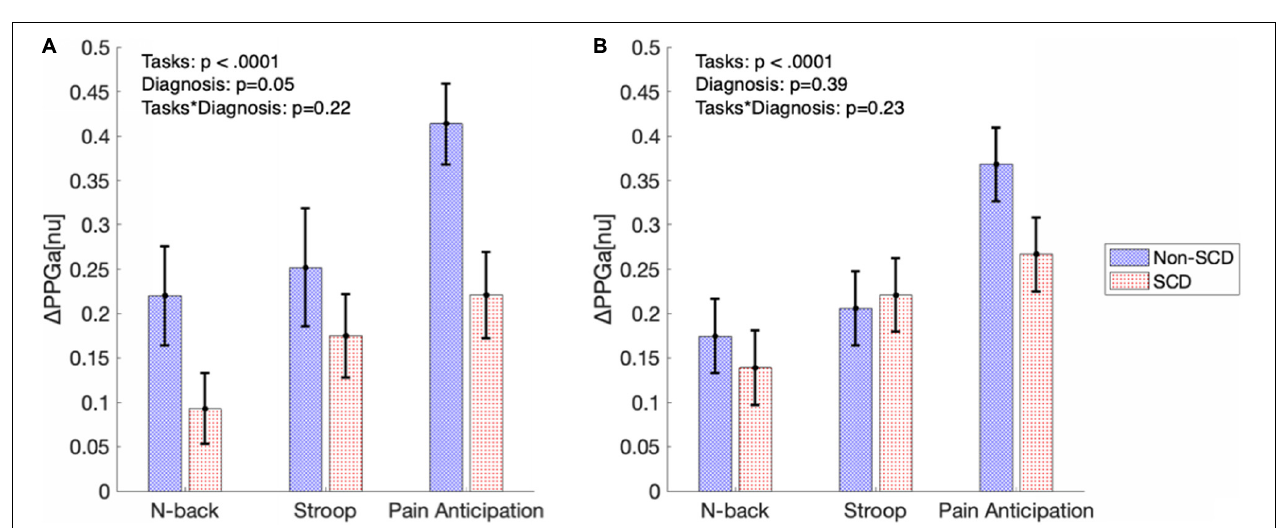
FIGURE 5 | The bar graphs show magnitude of vasoconstriction (mean ± SE) in SCD and non-SCD during MTS before (A) and after (B) adjusting for baseline